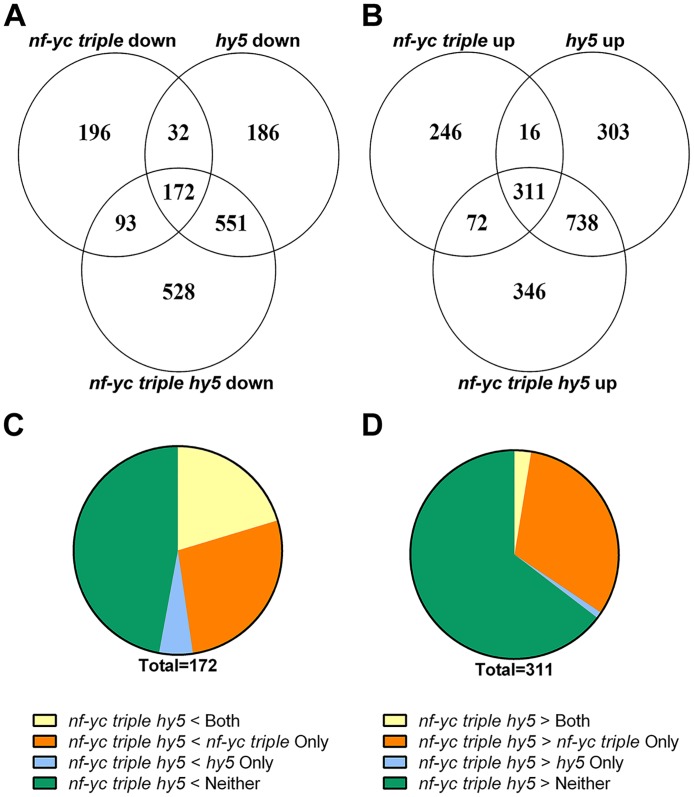
RNA-Seq analysis identified both shared and independently regulated targets for NF-YCs and HY5.Overlap between genes significantly A) down-regulated or B) up-regulated at least 1.5-fold in the nf-yc triple, hy5, and nf-yc triple hy5 backgrounds, relative to Col-0. Genes significantly differentially expressed in all three genotypes were then broken into regulatory groups according to the level of C) down-regulation or D) up-regulation in the nf-yc triple hy5 mutant relative to both nf-yc triple and hy5.